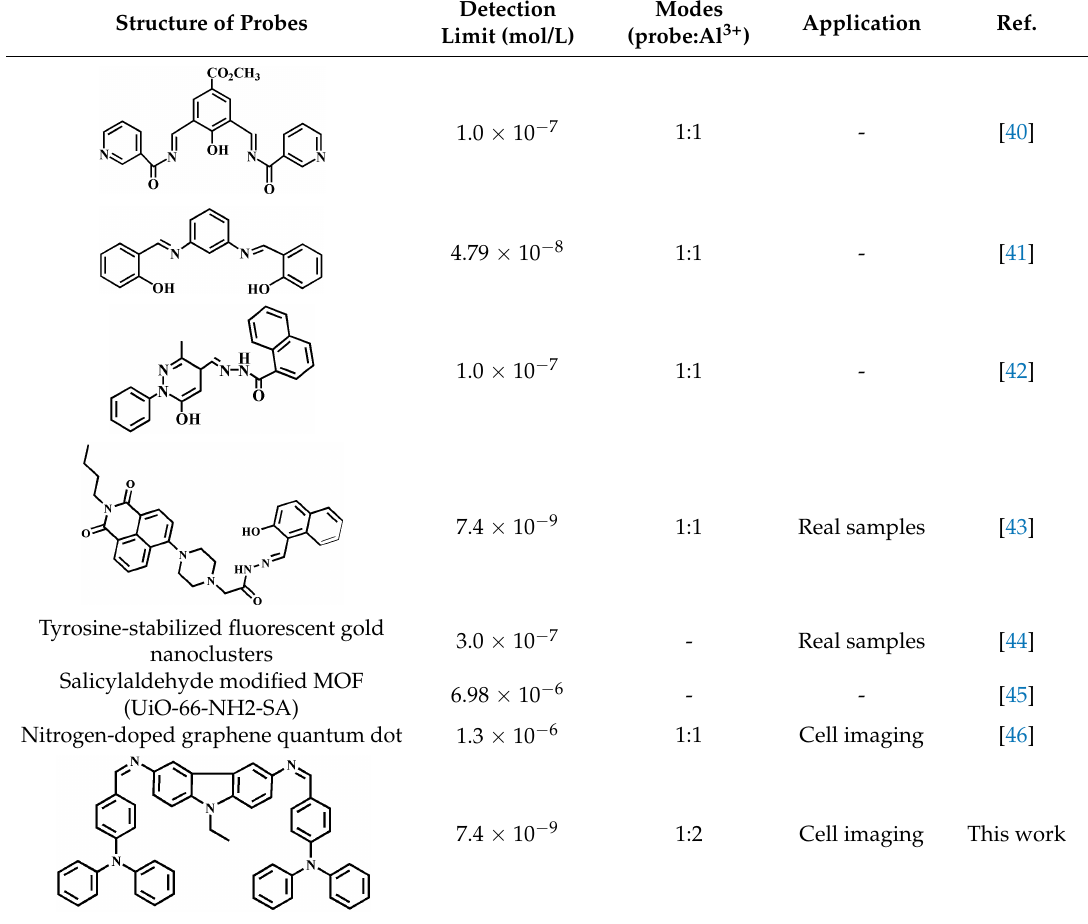
Table 1. Comparison of probes structure for Al 3+ detection by fluorescence method.